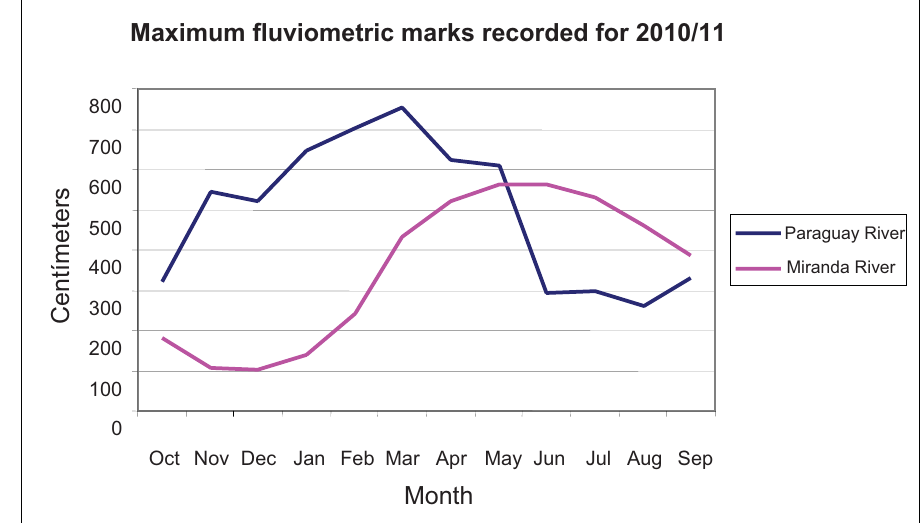
Figure 1. Fluviometric marks recorded on the Paraguay River at Ladário station, and on the Miranda River at Miranda city, for the 2010/2011 hydrological year of the